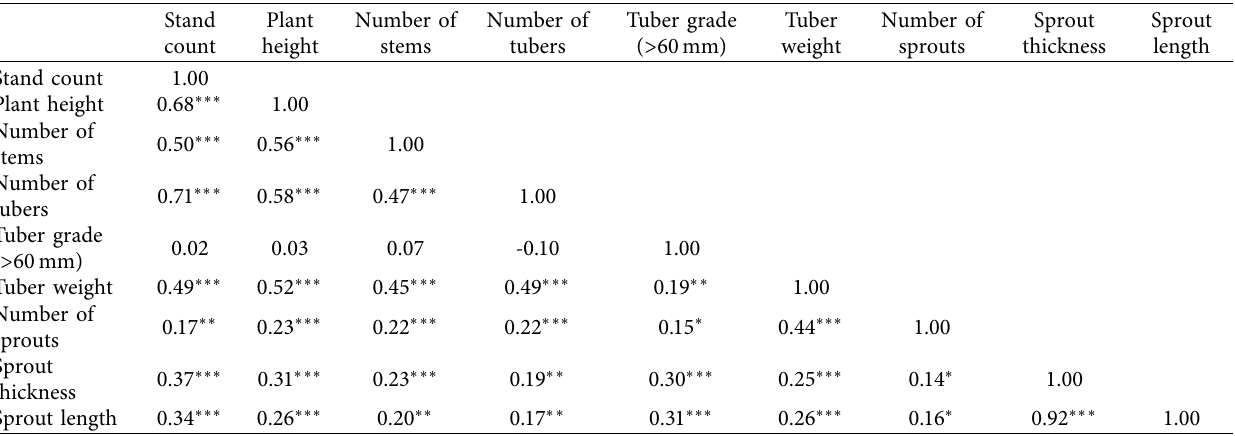
Table 14: Combined peasant correlation coefficient with probability values on sprout, growth, and yield